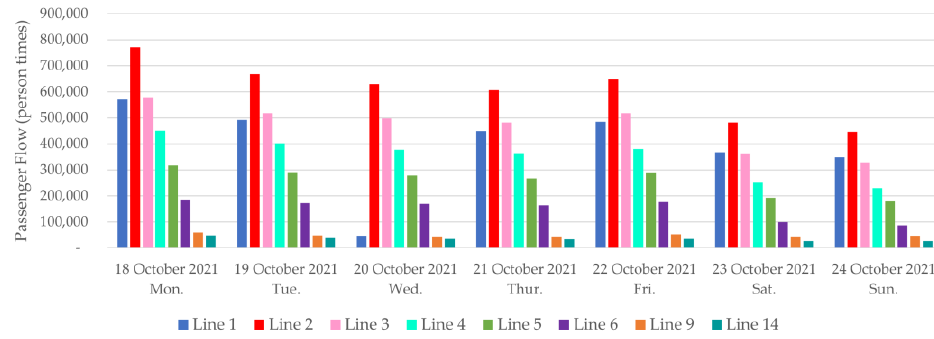
Figure 1. One week passenger flow statistics chart of Xi’an Metro. Source: Xi’an Metro Official Weibo Account, https://weibo.com/xianditie (accessed on 18 to 24 October 2021).